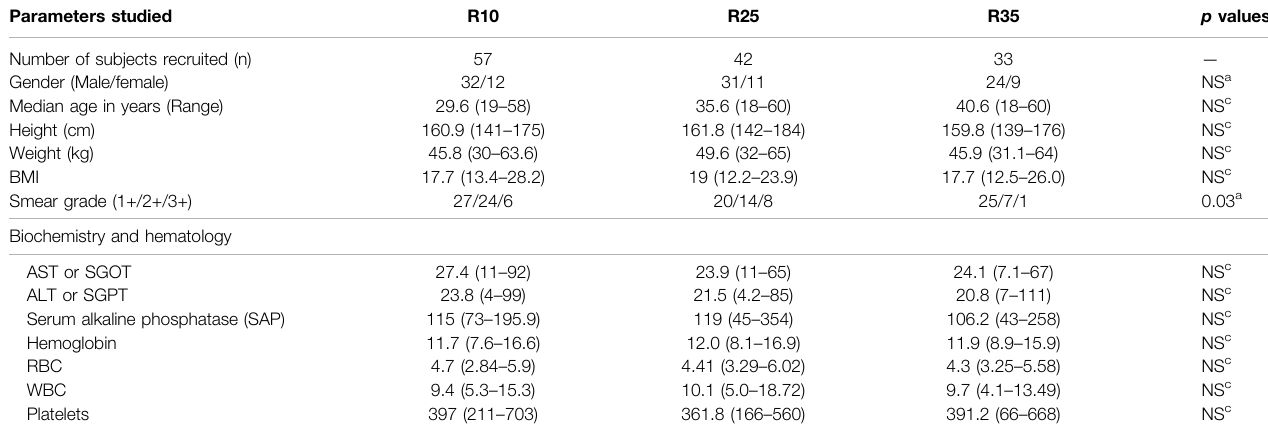
TABLE 1 | Demographics of the study population for cytokines, chemokines, and growth factors.